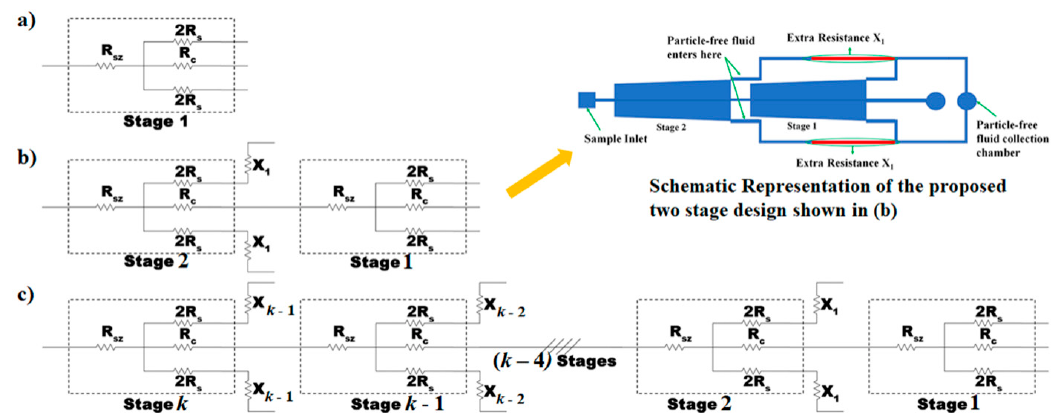
Figure 10. Schematic illustrating the strategies to enhance the yield. ( a ) Hydraulic resistance model of the device along with the side and central channels C’, S1’ and S2’ and is depicted as Stage-I. ( b ) Hydraulic resistance model when Stage-II being added to Stage-I and the representative schematic is shown in the inset. ( c ) Hydraulic resistance model when k such stages are present in the device.